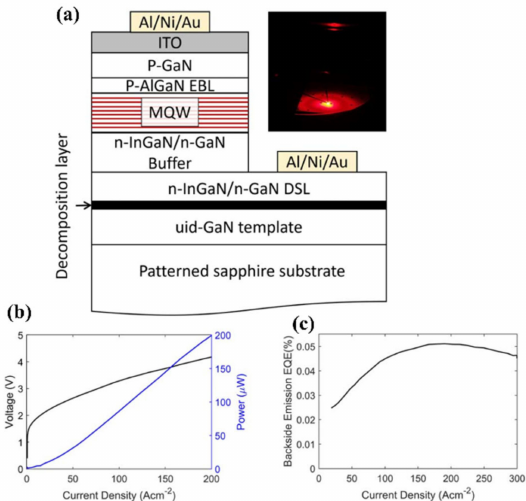
Figure 8. ( a ) Cross-sectional epilayer design; ( b ) voltage and power measured from backside vs. J; ( c ) backside emission EQE as a function of J . Copyright 2009 The Japan Society of Applied Physics